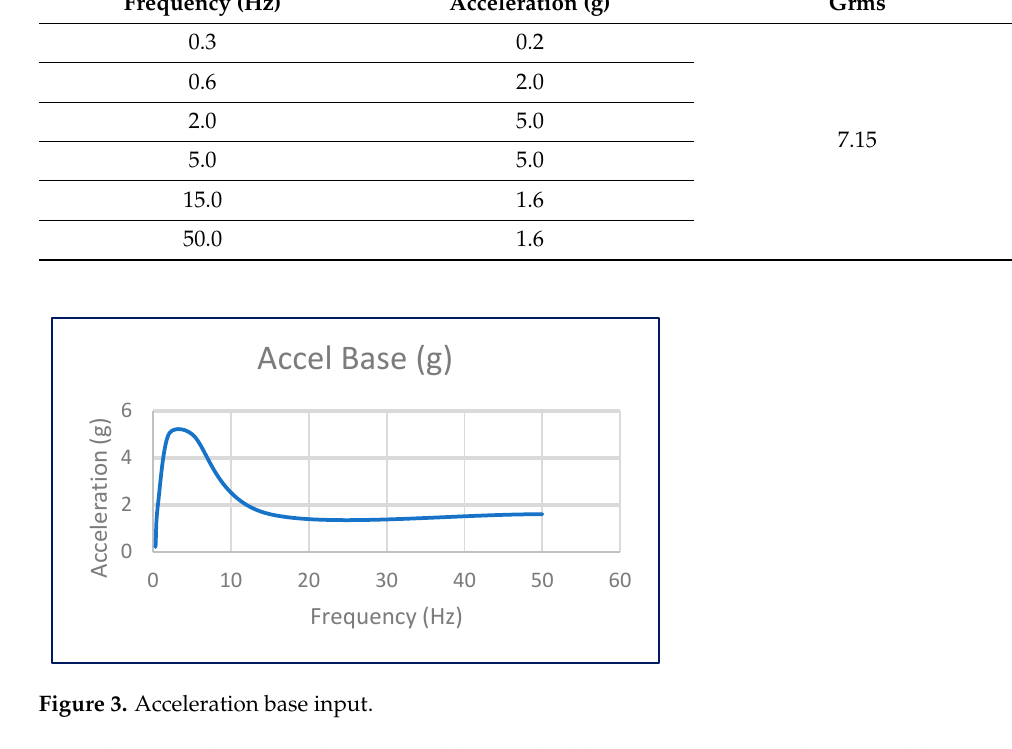
Table 1. Random vibration base input profile.